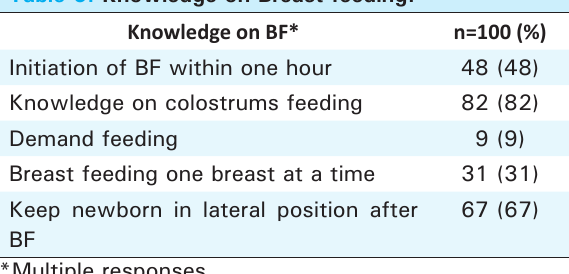
Table 6. Knowledge on Breast feeding.